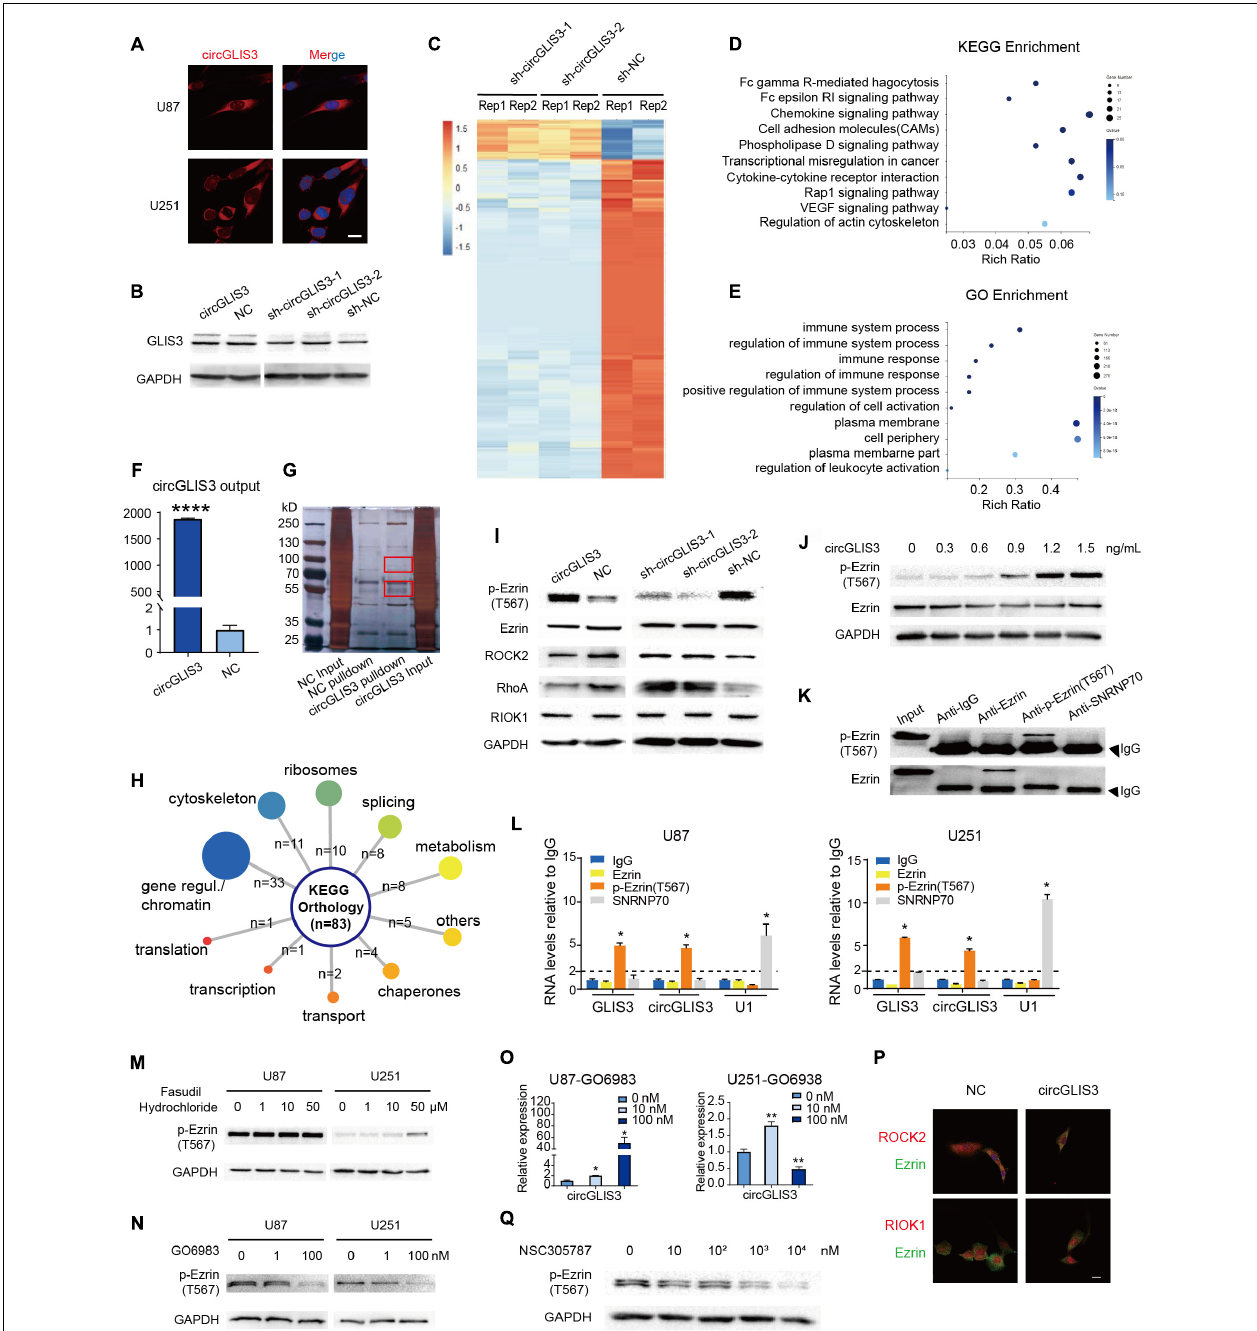
FIGURE 3 | CircGLIS3 directly binds with p-Ezrin(T567) and elevates the p-Ezrin(T567) level in glioma. (A) Fluorescence in situ hybridization (FISH) assay with Cy3-labeled circGLIS3 probe (magnification, × 640; scale bar, 10 µ m). (B) Western blot of GLIS3 protein after the upregulated or downregulated circGLIS3 level in U251 cells. (C) RNA-Seq analysis of U251 cells transfected by sh-circGLIS3 or sh-NC lentivirus. (D) KEGG and (E) GO enrichment analysis in U251 cells. (F) RNA pull-down experiments with U251 extract. Pull-down probe efficiency was determined by RT-PCR. (G) RNA pull-down experiments with U251 extract. Specific bands were identified by mass spectrometer. (H) Summary of circGLIS3 binding proteins according to KEGG. (I) Western blot detection after upregulated or downregulated circGLIS3 in U251. (J) Western blot detection of p-Ezrin(T567) in U87 transfected by concentration gradient circGLIS3 plasmid. (K) Western blot of RIP lysate by anti-Ezrin, anti-p-Ezrin(T567), anti-IgG, and anti-SNRNP70 antibodies. (L) RT-PCR analysis of Ezrin, p-Ezrin(T567), IgG-negative control, and SNRNP70-positive control immunoprecipitated RNA of U87 (left) and U251 (right). (M) Western blot of p-Ezrin(T567) in U87 and U251 after being treated with DMSO or fasudil hydrochloride for 2 days. (N) Western blot of U87 and U251 after treated with GO6983 for 2 days. (O) RT-PCR of U87 and U251 after being treated with GO6983 for 2 days. (P) Confocal microscope image of Ezrin and ROCK2 or RIOK1. Scale bar, 5 µ m. (Q) Western blot of p-Ezrin(T567) in U87 after being treated with NSC305787 for 9 h. The results are presented as the mean ± SEM of biological triplicate assays. * P < 0.05, ** P < 0.01, **** P < 0.0001.